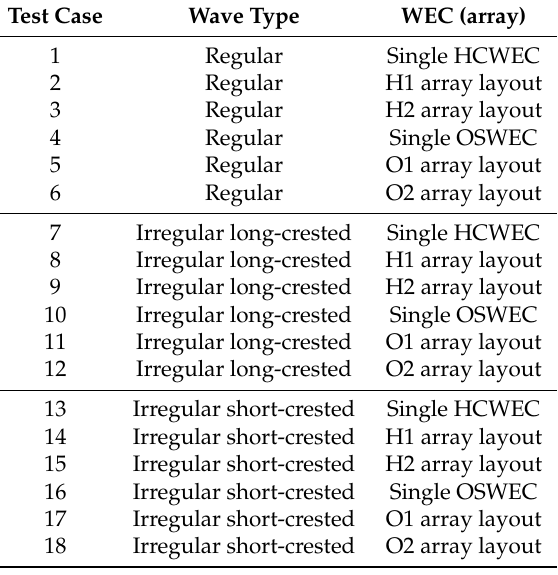
Table 3. Numerical test cases for the comparison of “far-field” effects